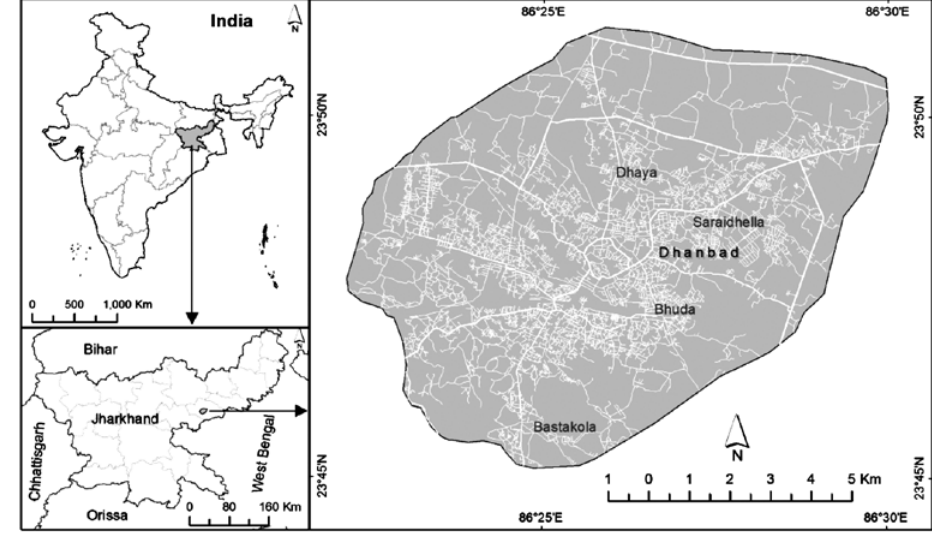
Fig. 1. Location of the study area